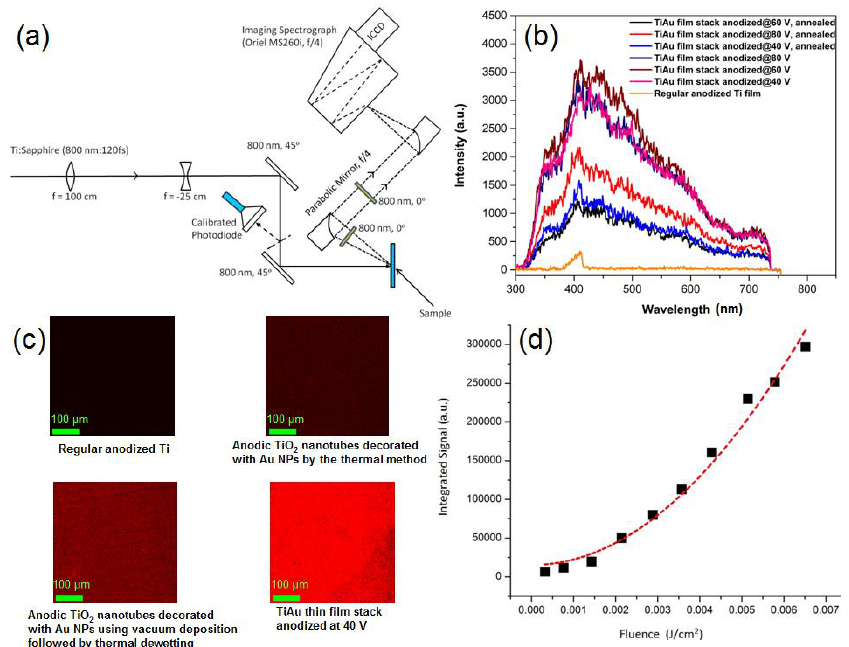
Figure 17. Two photon luminescence studies of Anodic Plasmonic Au–TiO 2 Engineered